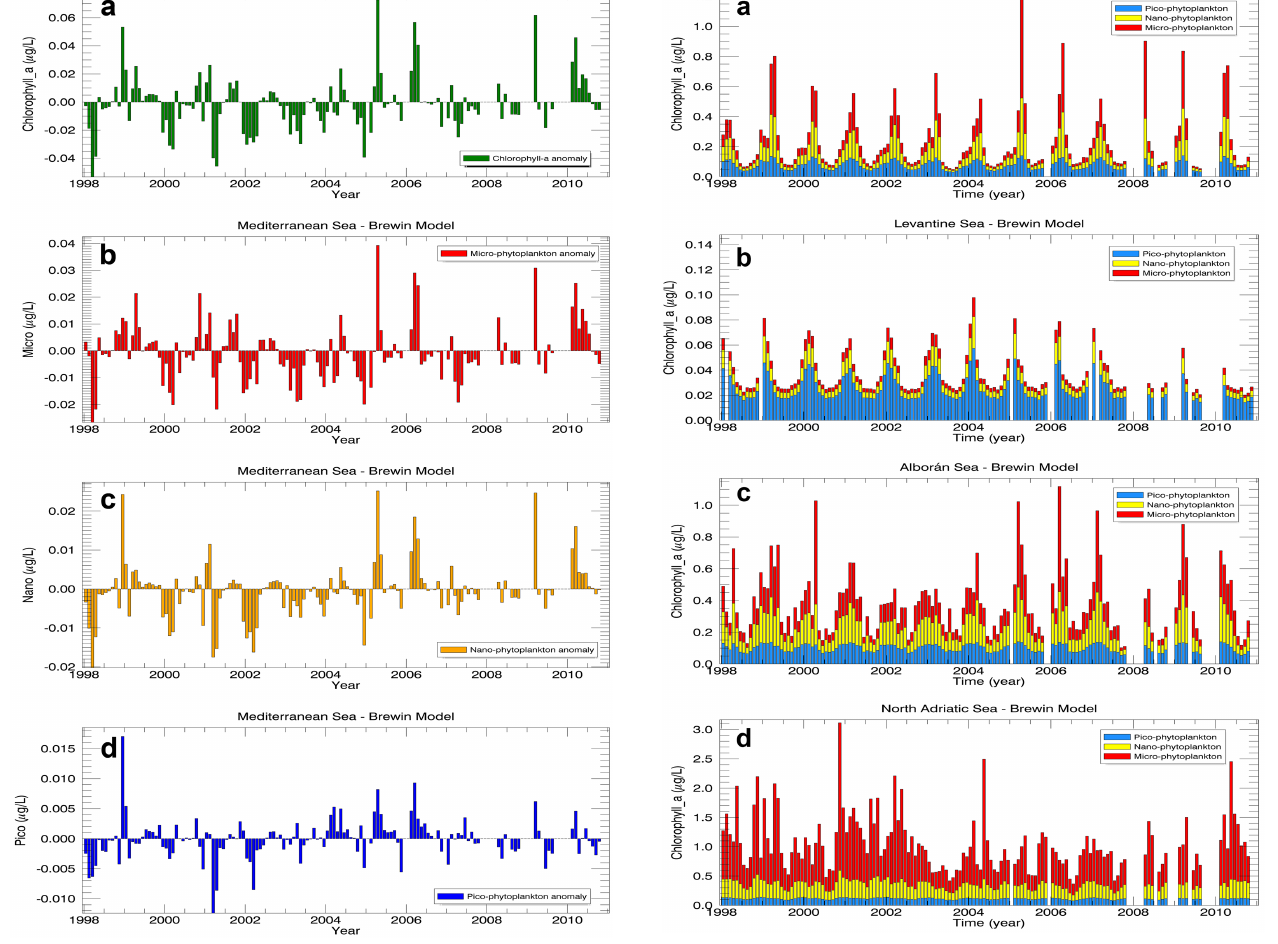
Figure 8. Monthly anomalies computed for the entire time series (1998–2010) over the Mediterranean Basin. Gaps in the time se- ries correspond to months where less than 90% of the observations were recorded in the basin. From top to bottom, there are the anoma- lies of TChl a , micro-phytoplankton contribution to TChl a , nano- phytoplankton contribution to TChl a , and pico-phytoplankton con- tribution to TChl a .